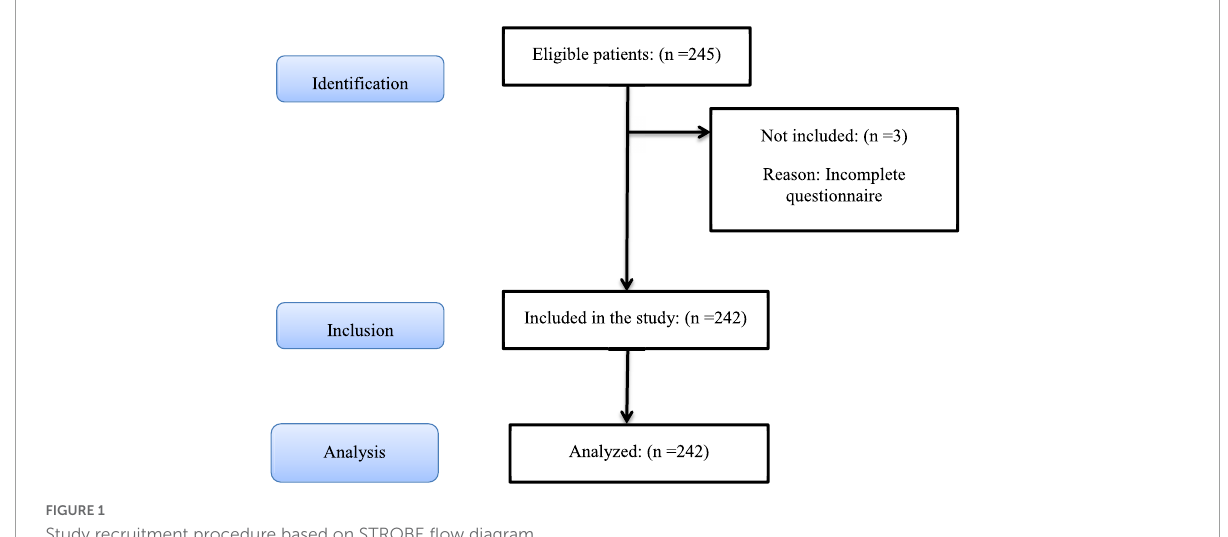
FIGURE1 Study recruitment procedure based on STROBE flow